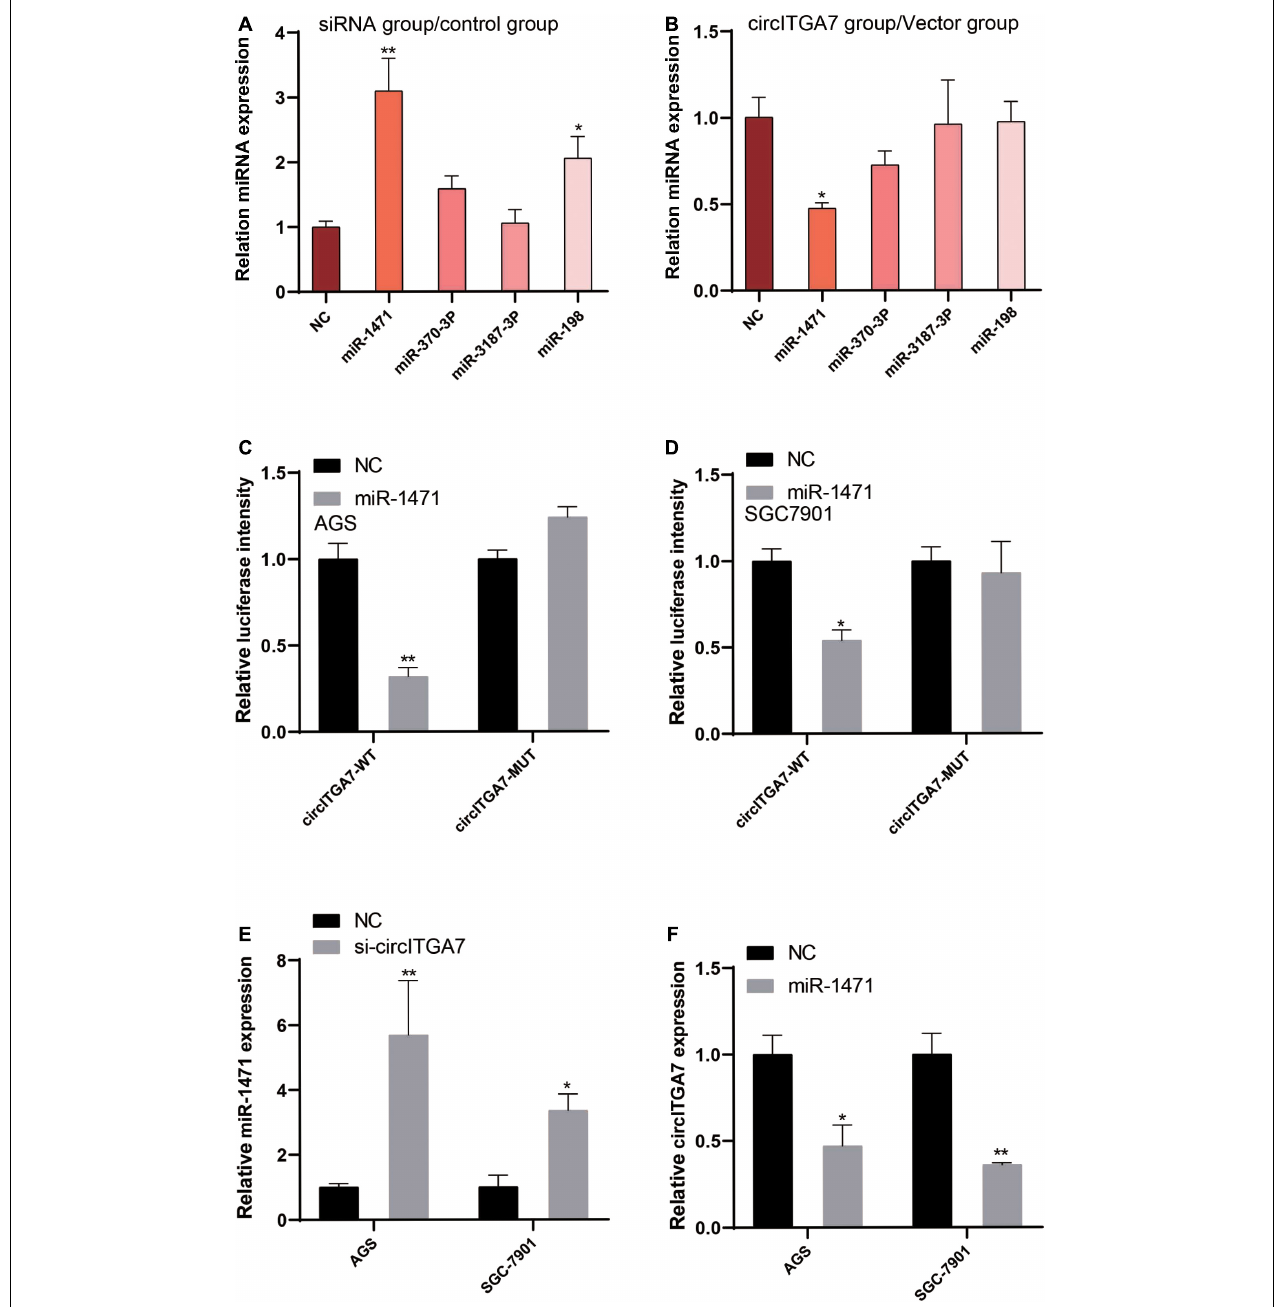
FIGURE 6 | CircITGA7 was a sponge for miR-1471. Expressions level of four miRNAs in AGS cells transfected with (A) siRNA or (B) circITGA7 * P < 0.05, ** P < 0.01. Overexpressed miR-1471 did not attenuate the luciferase activity driven by circITGA7 Mut, but significantly attenuated those driven by circITGA7 WT